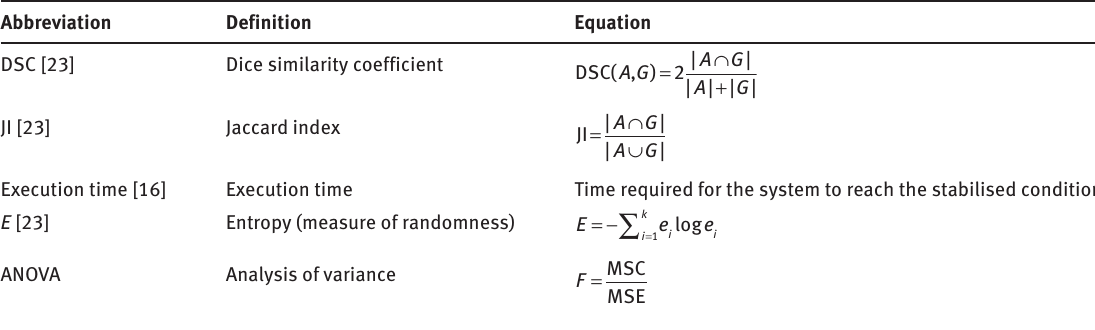
Table 2: Abbreviations, Definition, and Equations.